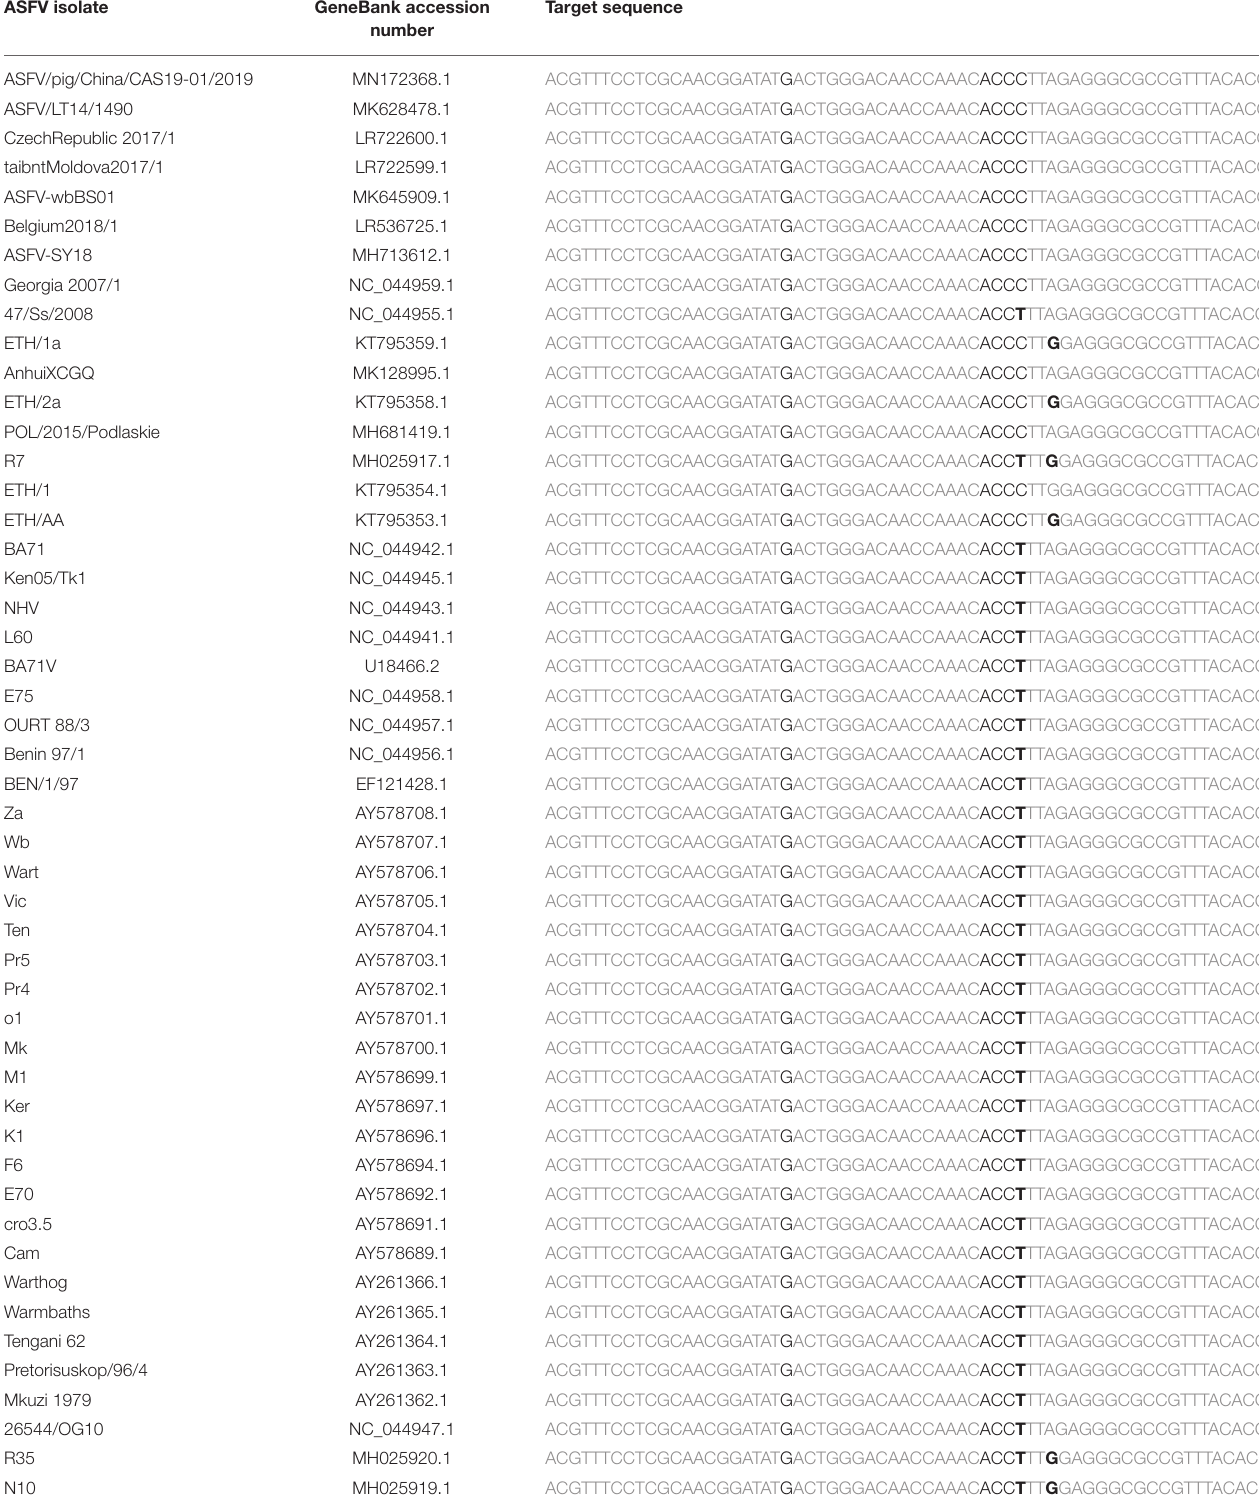
TABLE 1 | The primers and MGB probe were aligned with 53 ASFV epidemic strains and 5 other swine